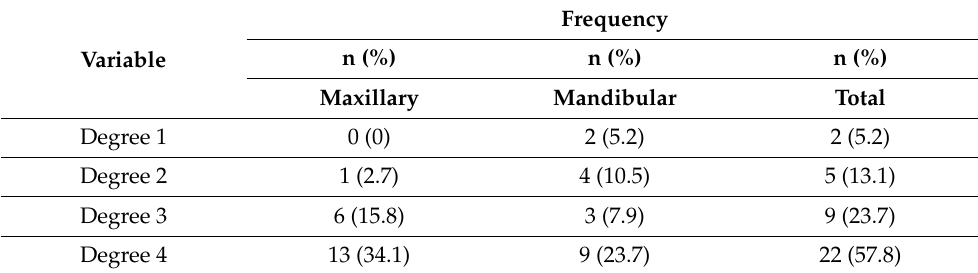
Table 2. Extent of gingival pigmentation (Hedin’s